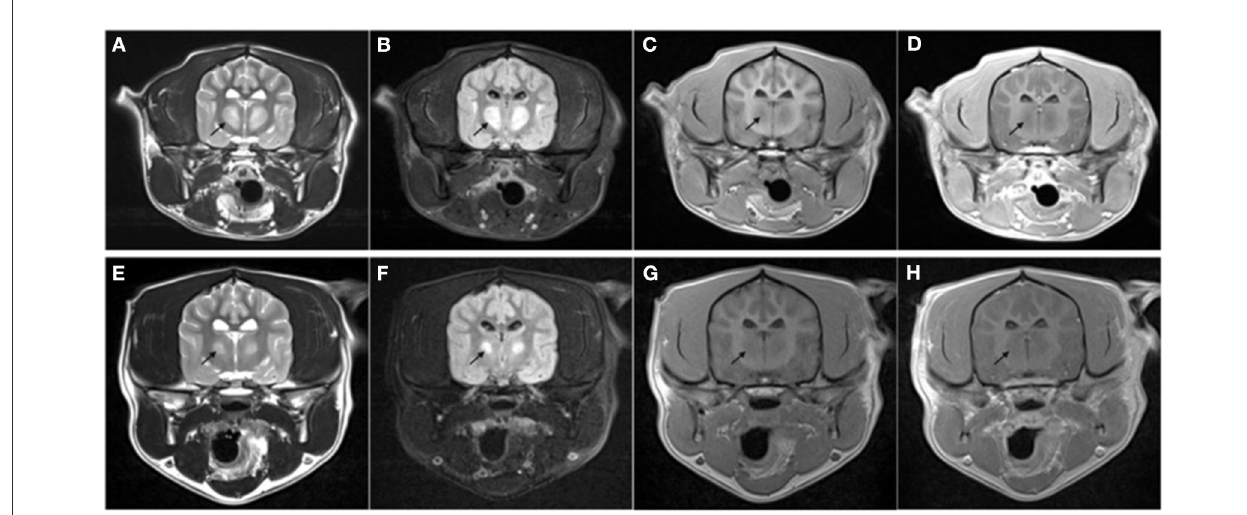
FIGURE1 Transverse MRI images performed on day 4 of hospitalization (A–D) and at recheck 130 days later (E–H) . The images are at the level of the thalamus. T2-weighted (A, E) , T2 FLAIR (B, F) , T1-weighted pre- (C, G) , and post- (D, H) administration of intravenous gadolinium. Note the bilateral symmetric T2W and T2-FLAIR hyperintense [arrow in (A, E) ], T1 hypointense non-contrast enhancing lesions present within the thalamus. The lesion was markedly reduced in size at follow-up MRI with the same MRI characteristics.